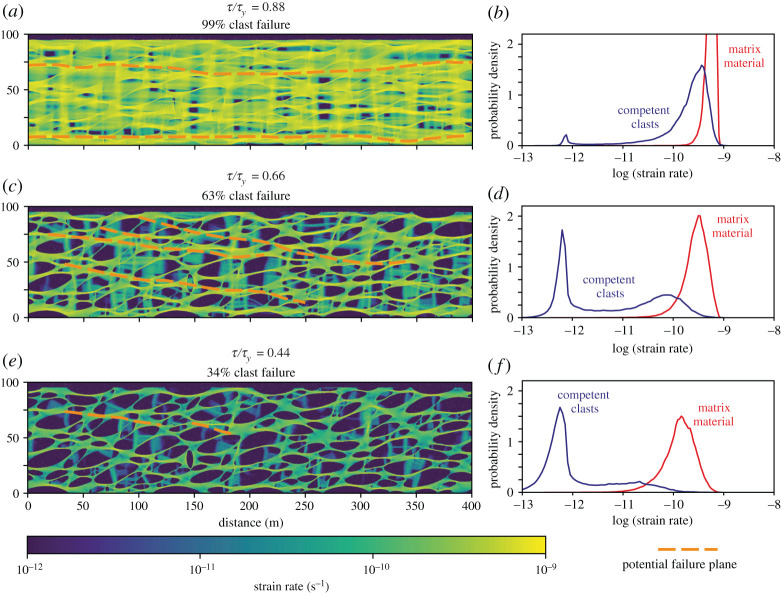
Plots of strain rate distribution within a linear-viscous shear zone, where the viscosity ratio between clasts and matrix is 103. Models are run at different ratios of driving stress (τ) to frictional yield stress (τy) of the competent phase. When τ/τy approaches 1 (a), frictional deformation dominates and allows uniformly high strain rates (b). Compare this to a small τ/τy where only ∼ 1/3 of clast volume is failing frictionally (e), and the strain rates are bimodal (f ), with much faster deformation in the weak, viscously flowing matrix. In the intermediate case (c), sufficient clast volume (greater than 50%) is failing to allow potential for through-going discrete fractures to form locally and transiently, linking fracturing clasts through the matrix material. In this case, the probability density distribution of strain rate (d) shows a narrow peak for clasts deforming slowly and viscously, and a broader peak for faster deformation in clasts that are undergoing some level of frictional deformation. The strain rate is given in units of s−1 assuming a matrix viscosity of 1017 Pa s and τy = 160 MPa [97]. (Online version in colour.)